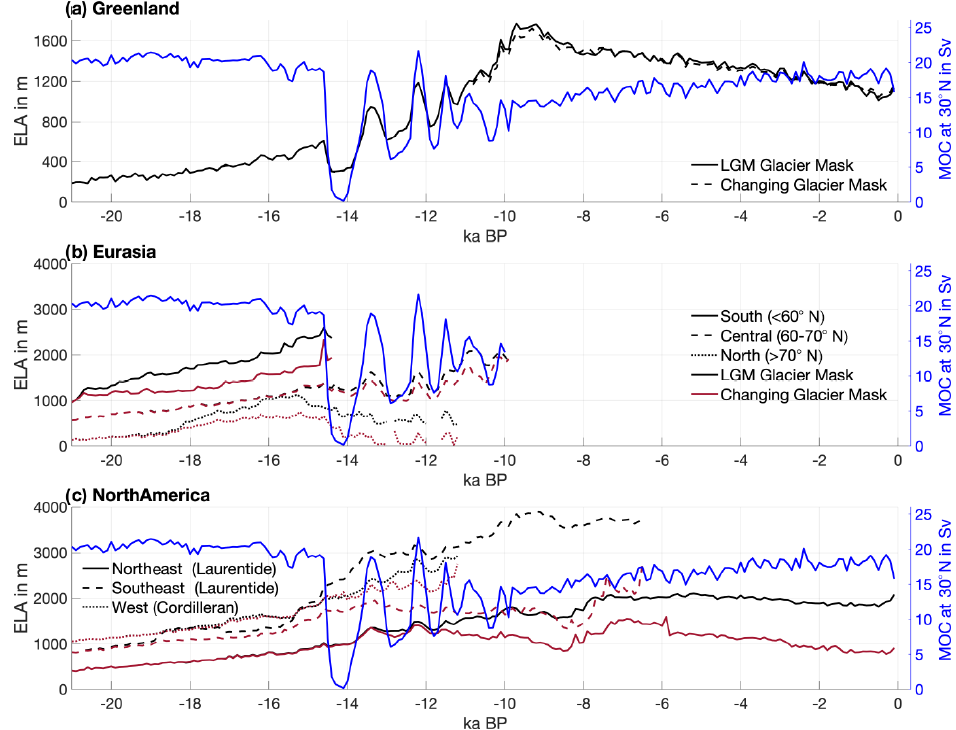
Figure A6. Similar to Figs. 3 and 8 but for EBM MPI-ESM-CR